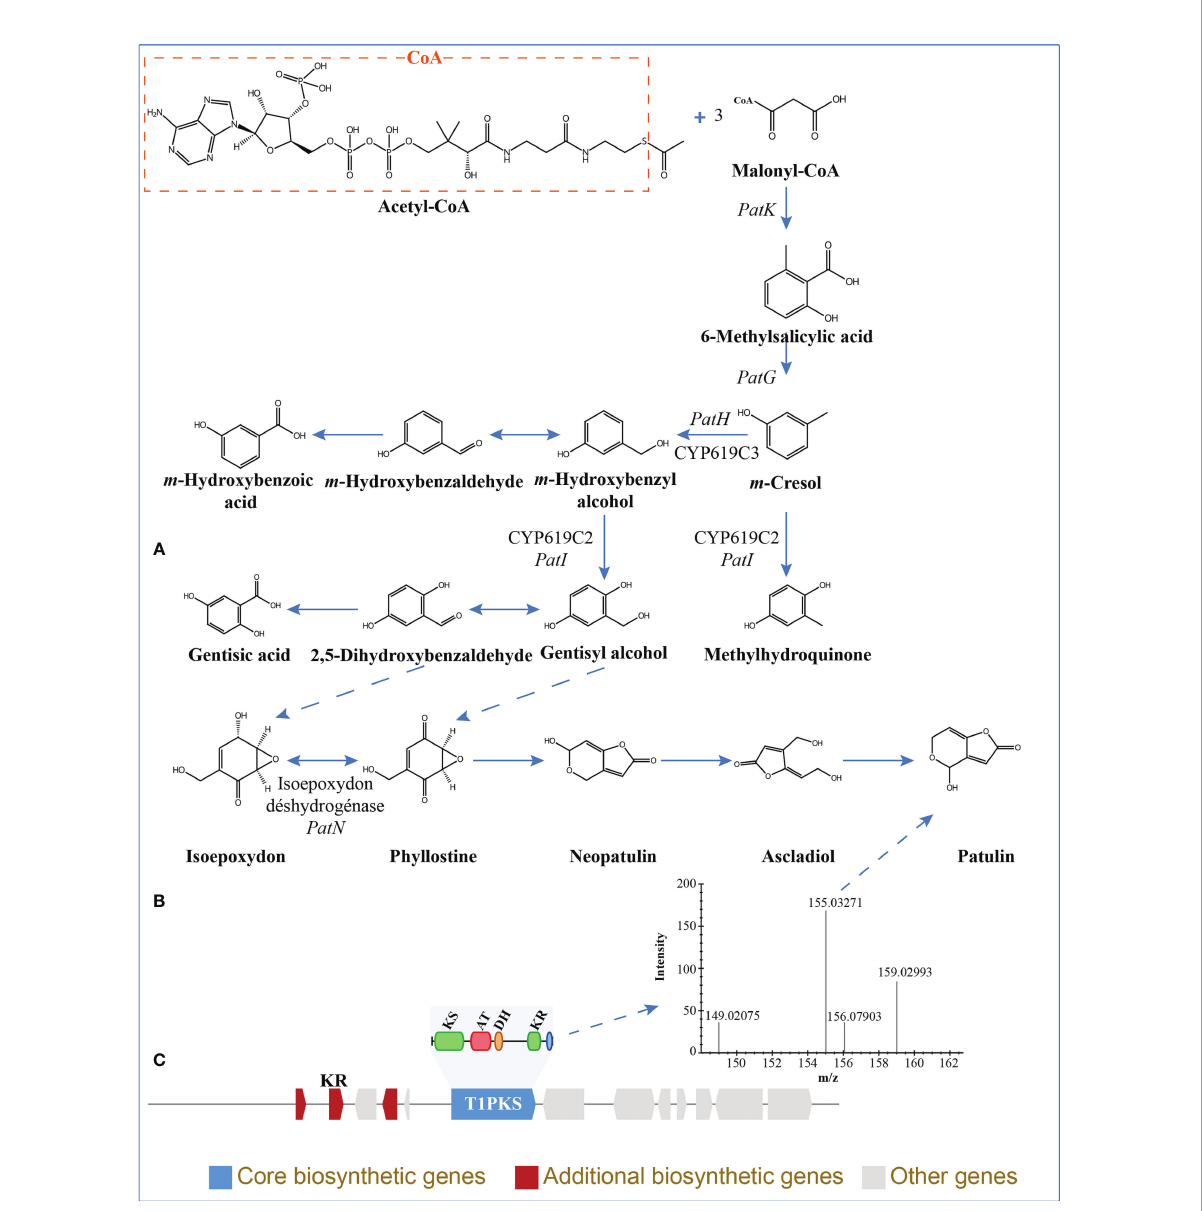
FIGURE 6 Patulin in Epicoccum latusicollum HGUP191049. (A) Biosynthetic pathways of patulin (Puel et al., 2010; Nielsen et al., 2017). (B) Non-targeted metabolic pro fi ling spectrum. (C) Schematic representation of the putative BGC of patulin (cluster 16). KS, ketosynthase; AT, acyl transferase; DH, dehydratase; KR, ketoreductase; T1PKS, type I polyketide